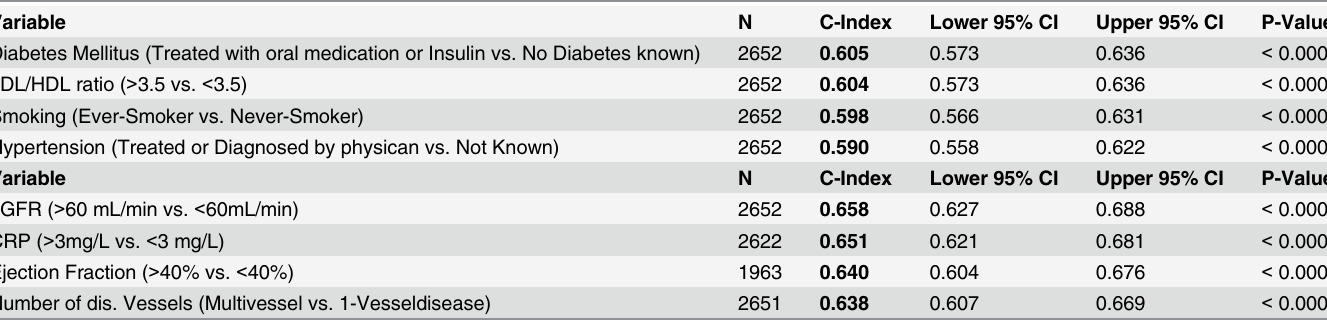
Table 5. Comparison of the C-Index regarding cardiovascular events vs. no events during follow-up in the stable angina cohort. Stable Angina Pec- toris Cohort (N = 2652). Variable N Lower 95% CI Upper 95% CI P-Value Diabetes Mellitus (Treated with oral medication or Insulin vs. No Diabetes known) < 0.0001 LDL/HDL ratio ( > 3.5 vs. < 3.5)